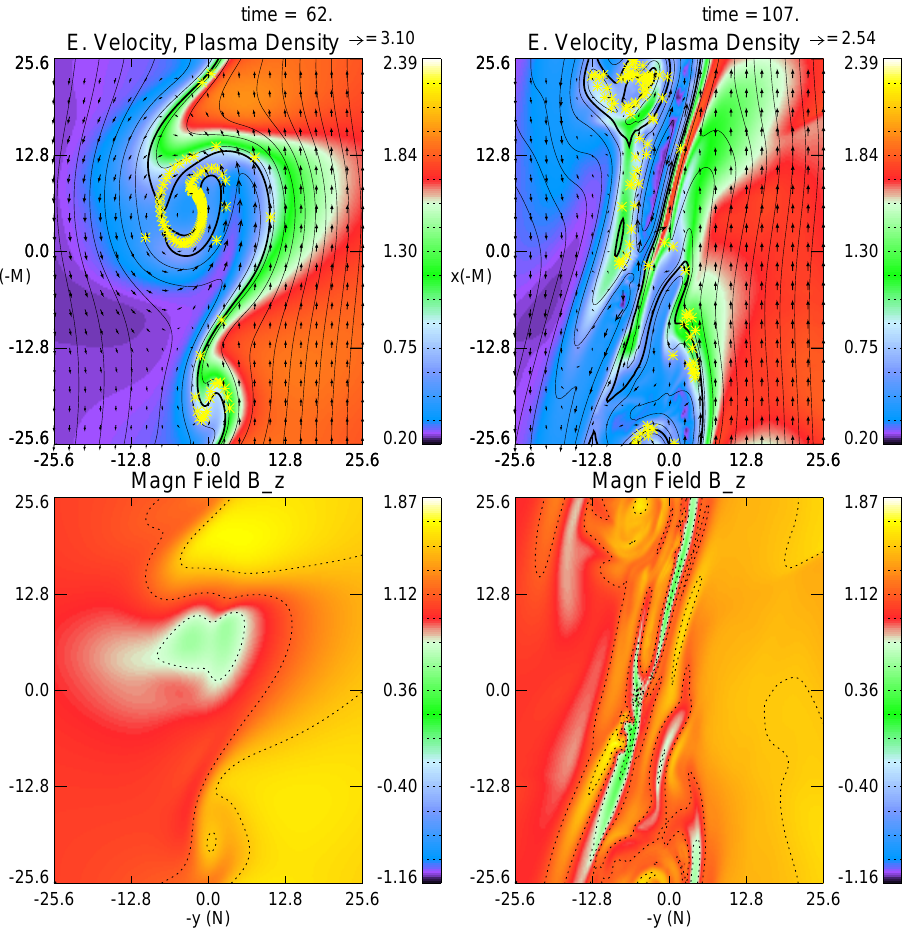
Fig. 6. KH vortex at t/τ A ≈ 62 and at t/τ A ≈ 107 for Run 5. Lines are magnetic field lines projected to x,y -plane and arrows are electron velocity vectors. Color code represents plasma density (upper panel) and z -component of the magnetic field (lower panel).